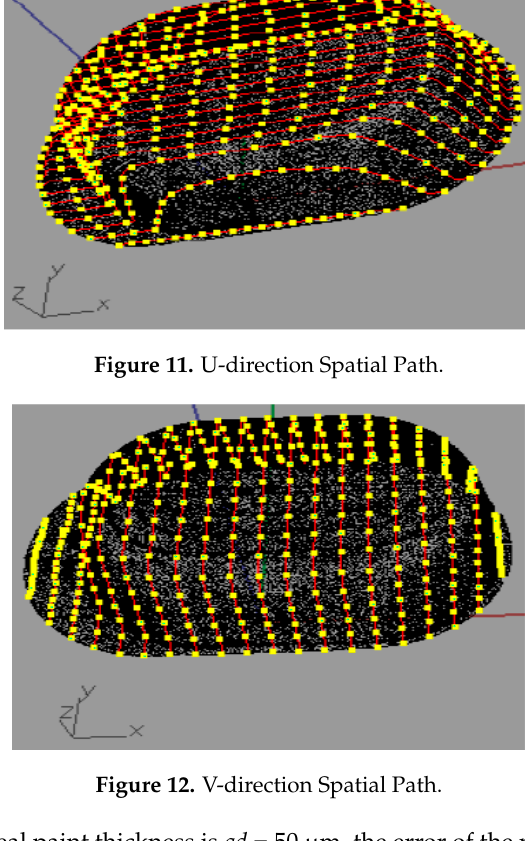
Figure 10. The Curved Surface Modeling Diagram of the Workpiece.